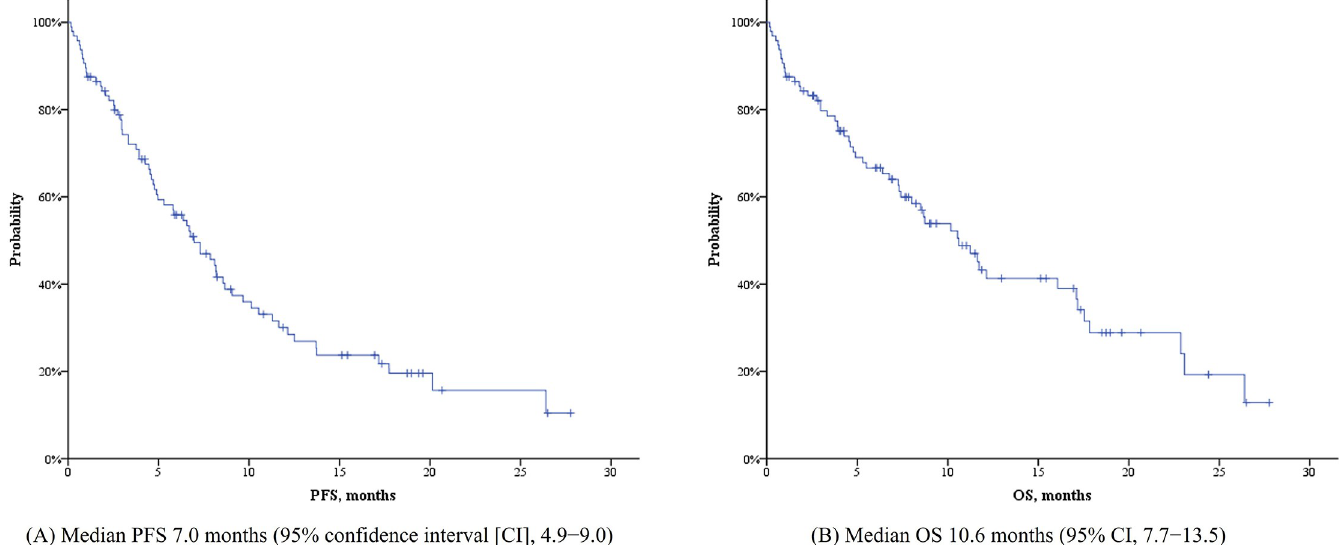
Fig 1. Progression-free survival (PFS, A) and overall survival (OS, B). (A) Median PFS 7.0 months (95% confidence interval [CI], 4.9 − 9.0) (B) Median OS 10.6 months (95% CI, 7.7 − 13.5).